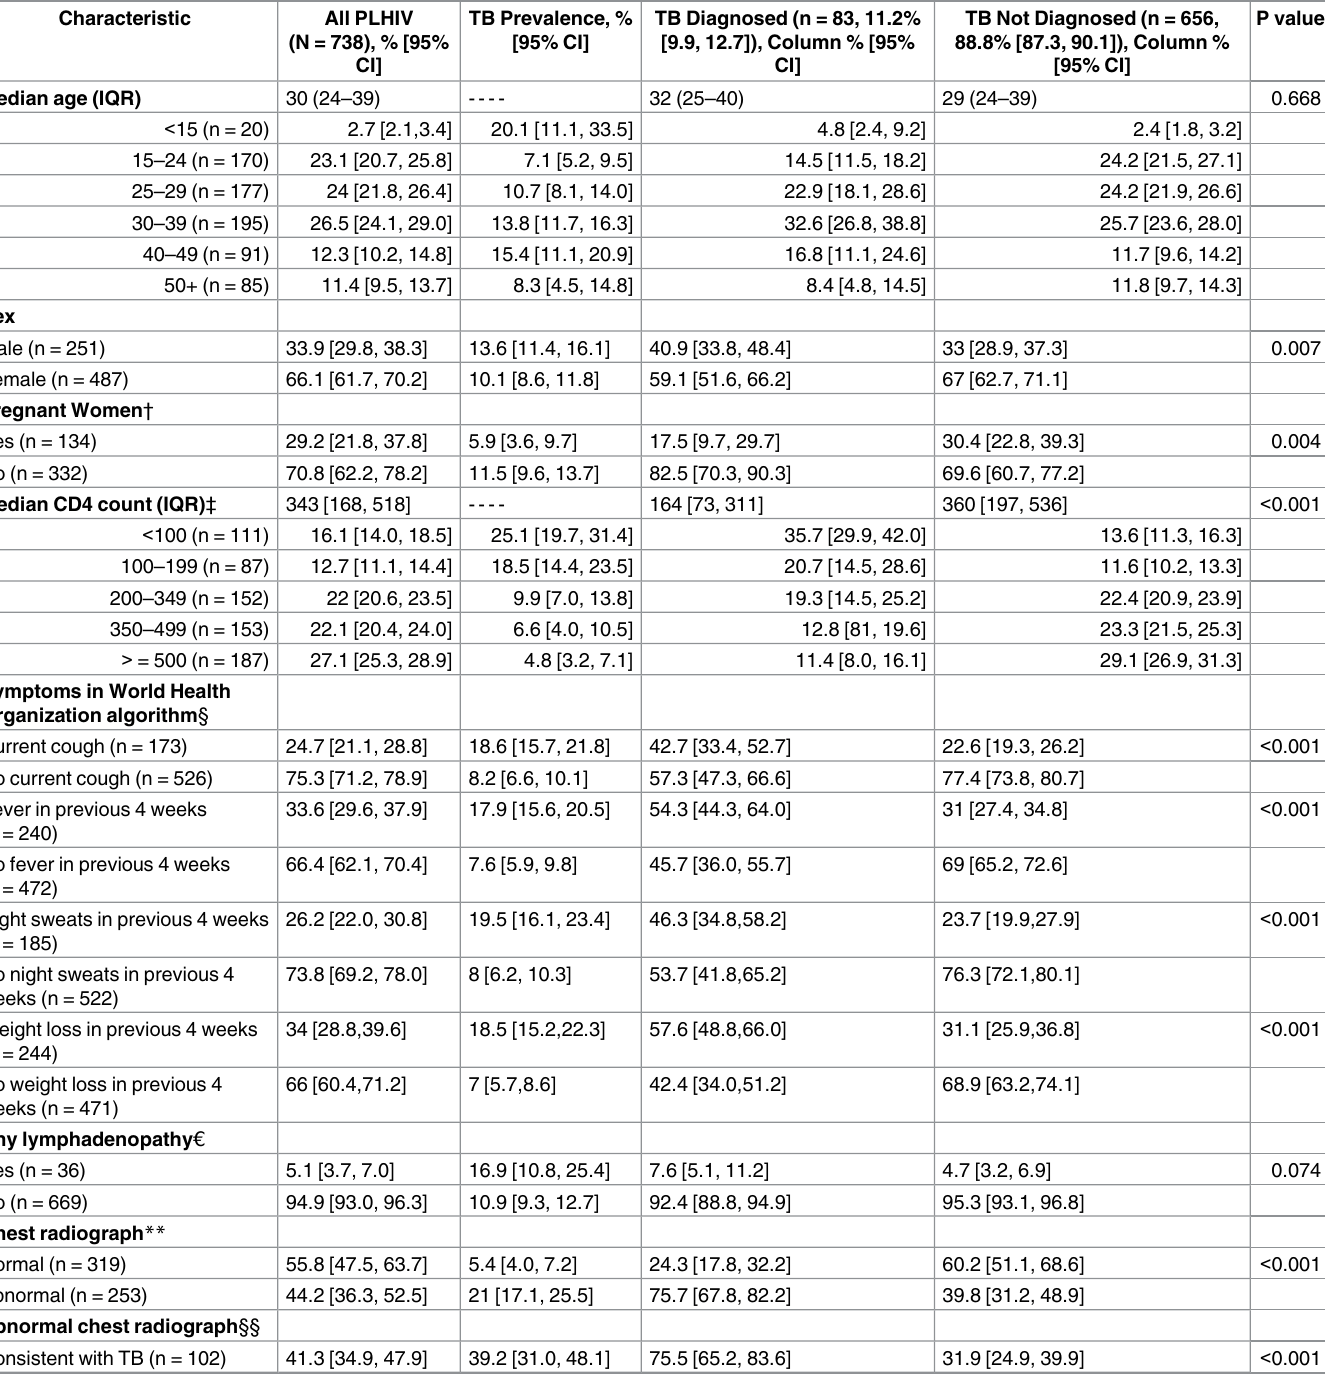
Table 1. Characteristics of People Living with HIV (PLHIV) According to Tuberculosis (TB) Diagnosis.